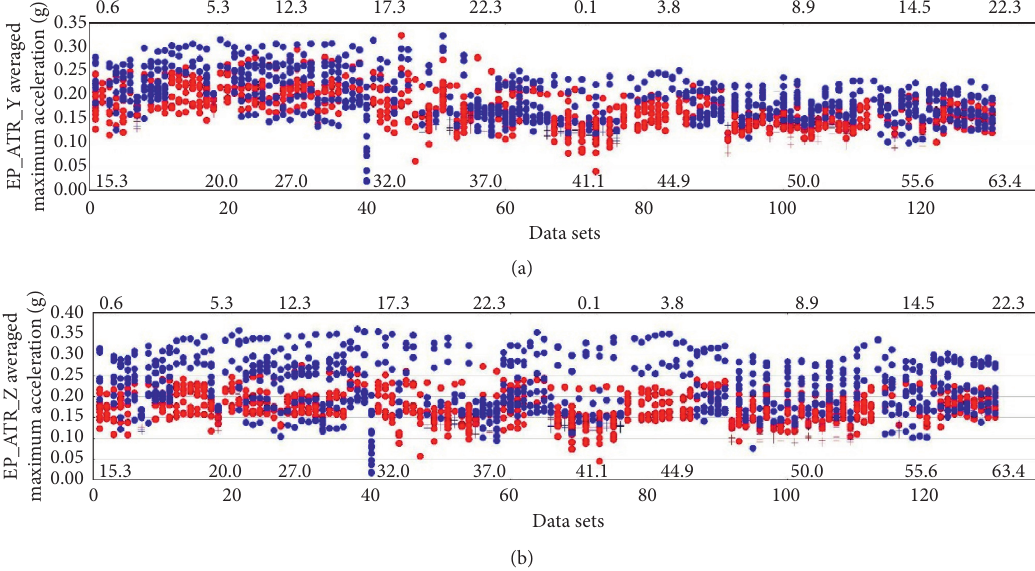
Figure 11: Unfiltered acceleration on CBSE traction converter in (a) lateral and (b) vertical